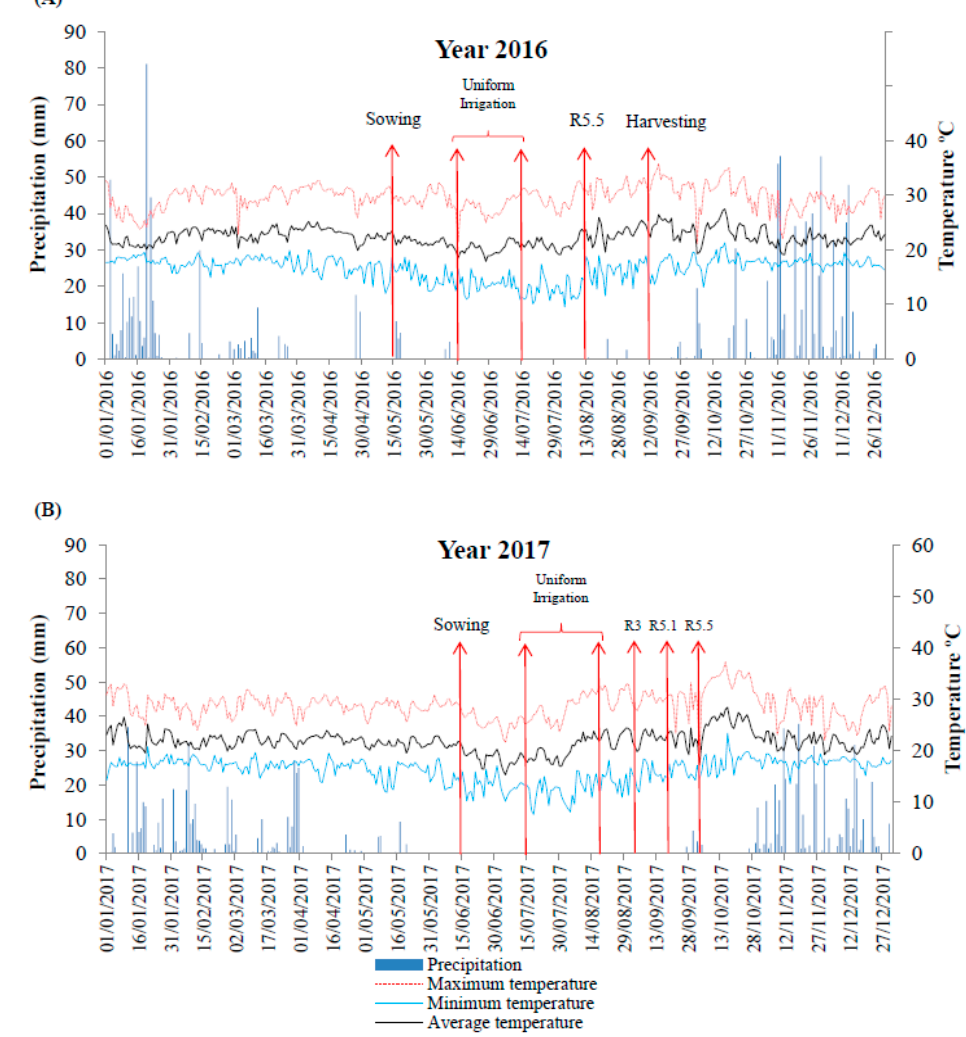
Figure 1. ( A ) Precipitation, maximum, minimum and average temperatures, rainfall and the sowing, evaluation and harvesting dates of soybean plants in 2016 and ( B ) 2017.